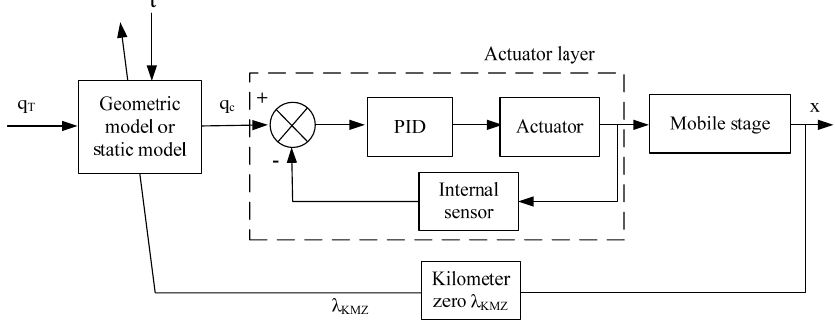
Figure 5. Block diagram of the system with adaptive model using